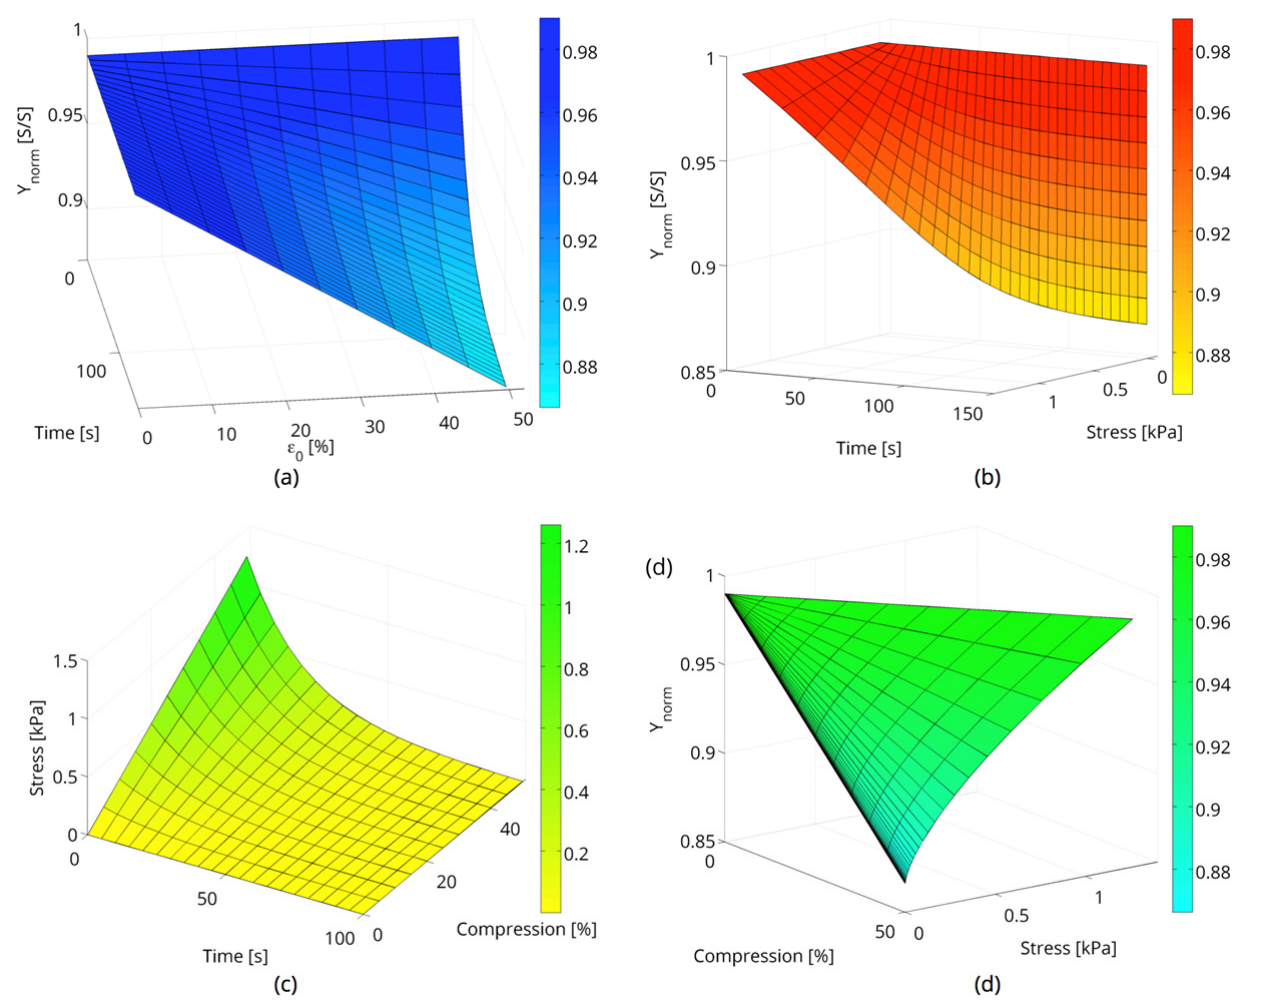
Fig. 13. The empirical model derived for (a) normalized admittance as a function of time and initial strain, (b) normalized admittance as a function of time and stress, (c) stress as a function of time and compression, and (d) normalized admittance as function of stress. Each relationship shown here fit the data well (in all cases R 2 > 0.95). From empirical models presented above and the theoretical modeling presented in equations (), the underlying physical changes of the phantom can be determined and predicted with a high degree of certainty through passive electric properties measured via impedance